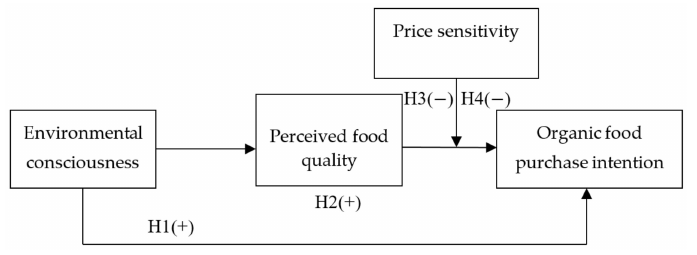
Figure 1. Research